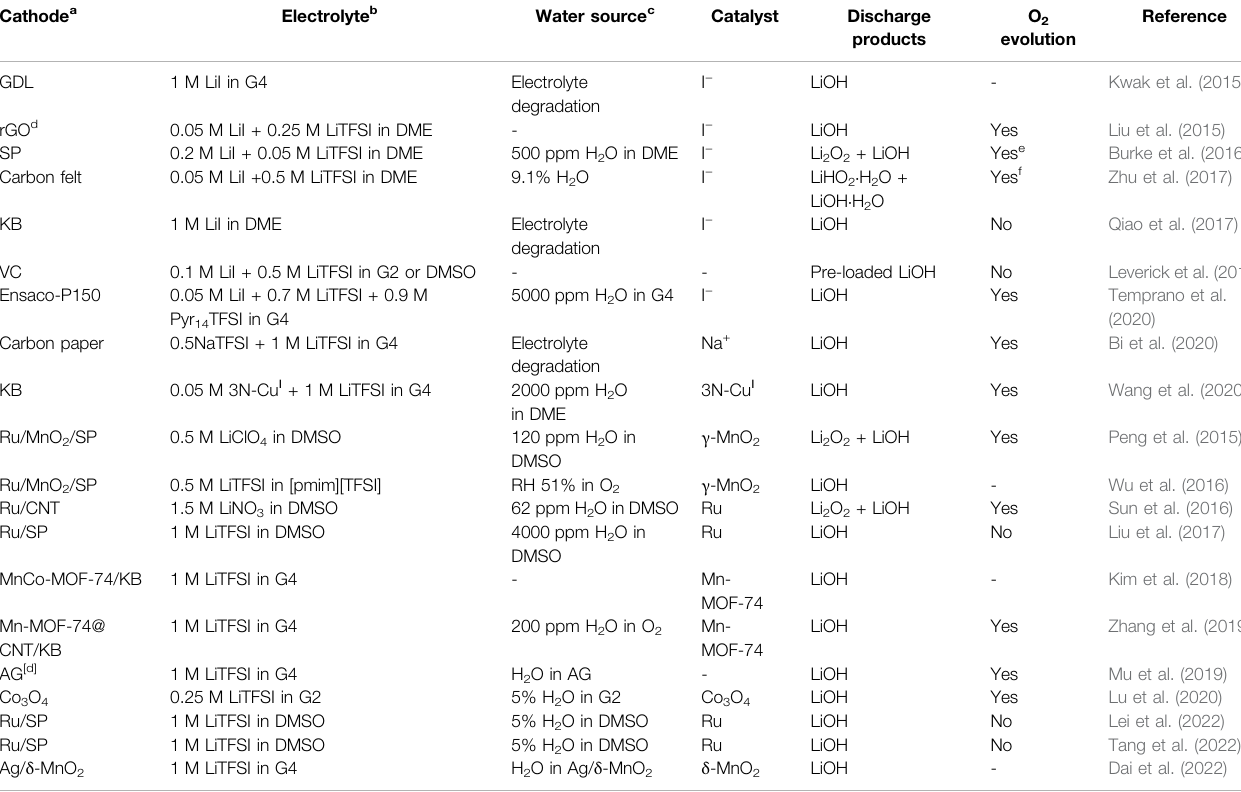
TABLE 1 | Summary of representative LiOH chemistry in Li − O 2 batteries. Cathode